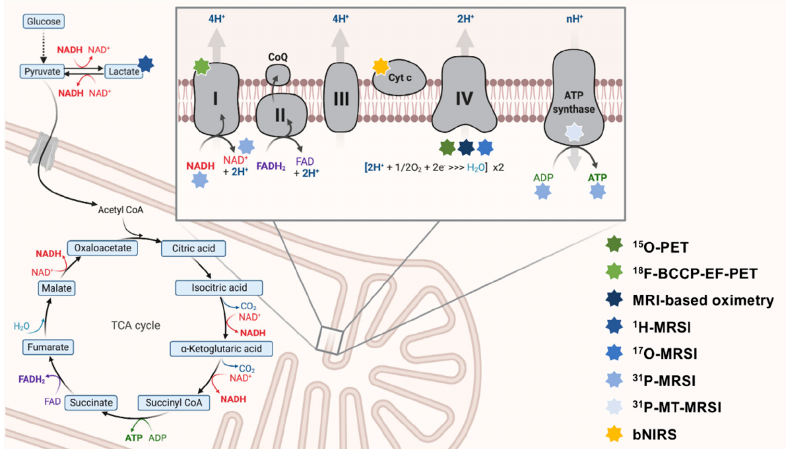
Figure 1. The interconnectedness of mitochondrial metabolism and OXPHOS-targeted neuroimaging approaches. Here, key aspects of OXPHOS are depicted. The ETC is schematically magnified (right upper corner). Multi-colored stars (legend: right-lower corner) indicate the respective neuroimaging modalities employed to map this particular aspect of metabolism. 18 F-BCCP-EF: 2-tert-butyl-4-chloro- 5-(6-(2-(2( 18 F)fluoroethoxy)-ethoxy]-pyridine-3-ylmethoxy)-2H-pyridazine-3-one. ADP: adenosine diphosphate. ATP: adenosine triphosphate. bNIRS: broadband near-infrared spectroscopy imaging. CoQ: coenzyme Q10. Cyt c: cytochrome c. ETC: electron transport chain. FAD/FADH 2 : flavin